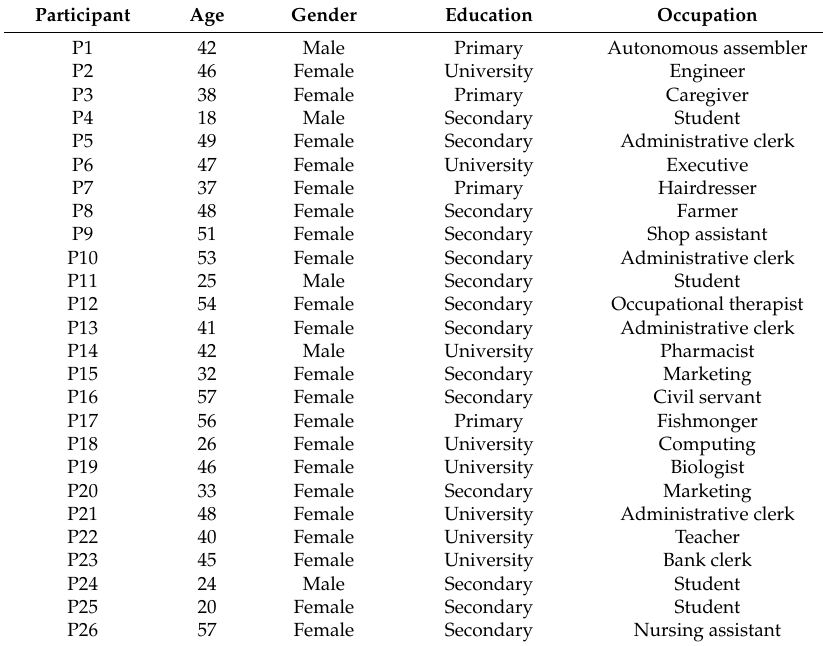
Table 2. Participants’ sociodemographic characteristics.